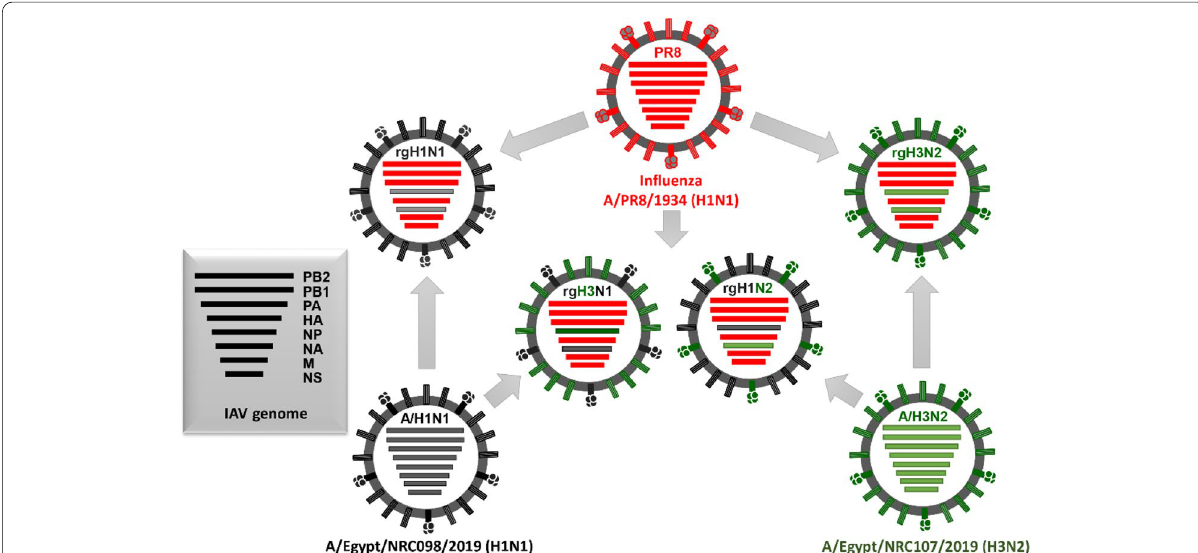
Fig. 5 Graphical representation of the parental and rescued viruses that were tested as candidate vaccine seed strains